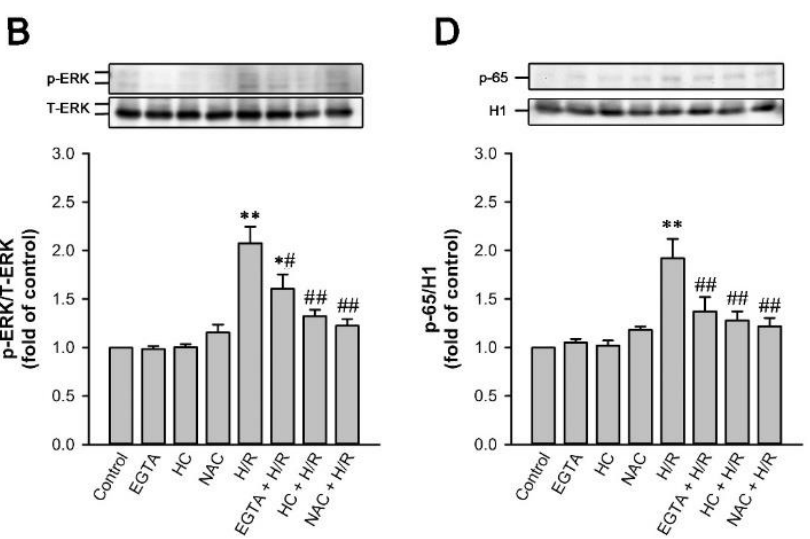
Figure 9. ERK/JNK/NF- κ B pathway is vital for the TRPA1-mediated induction of IL-8 by H/R in HK-2 cells. In all panels HK-2 cells were incubated under normoxia conditions as control or exposed to 2.5% O 2 for 6 h, followed by 4 h of reoxygenation. ( A ) In 6 study groups, cells were pretreated with PD98059 (PD, an ERK inhibitor; 10 µ M), SP600125 (SP, a JNK inhibitor; 10 µ M) or BAY11-7085 (BAY, a NF- κ B inhibitor; 10 µ M). ( B – D ) In 6 study groups, cells were pretreated with EGTA, HC-030031 (HC) or N-acetyl-cysteine (NAC). Protein expression was analyzed by ELISA ( A ) or Western blot ( B – D ). Activation of ERK and JNK was indicated by increased phosphorylation of these kinases, whereas NF- κ B activation was indicated by the increased presence of p65 subunit in the nucleus. Data in each group are as the mean ± SEM from 5 independent experiments. * p < 0.05 versus the control group; ** p < 0.01 versus the control group; # p < 0.05 versus the H/R group without drug pretreatment; ## p < 0.01 versus the H/R group without drug pretreatment. ERK, extracellular